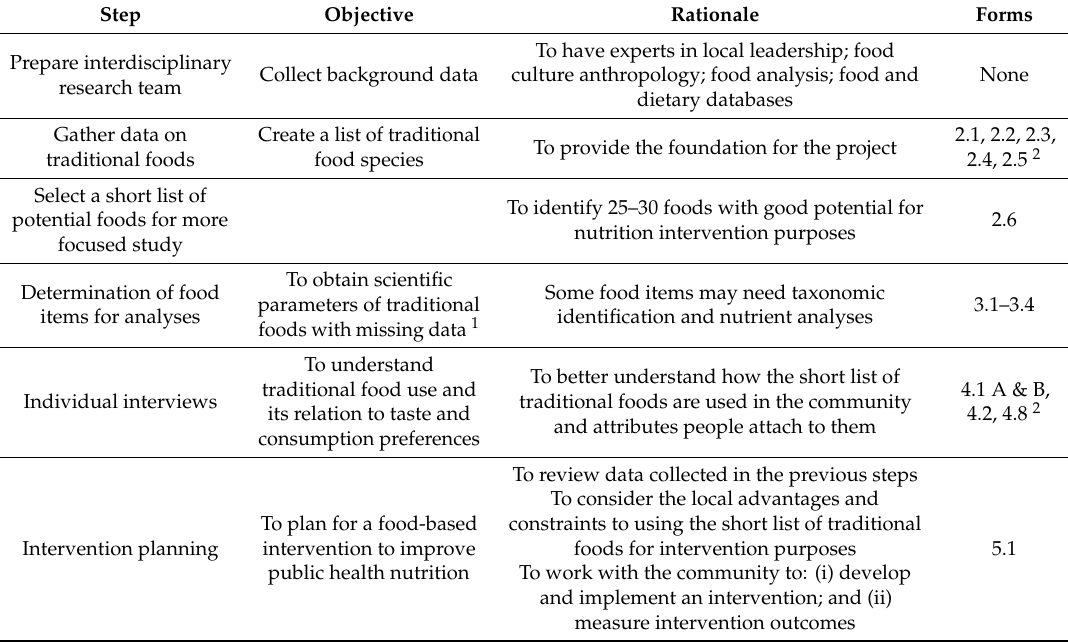
Table 1. Key features and brief summary of Guidelines for Procedures for Documenting Traditional Food Systems of Indigenous Peoples: International Case Studies.